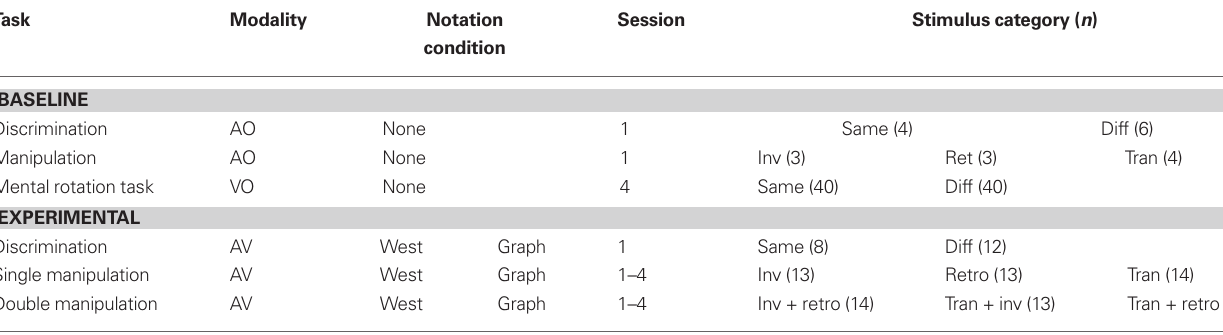
Table 6 | stimuli and conditions for the baseline and experimental melodic